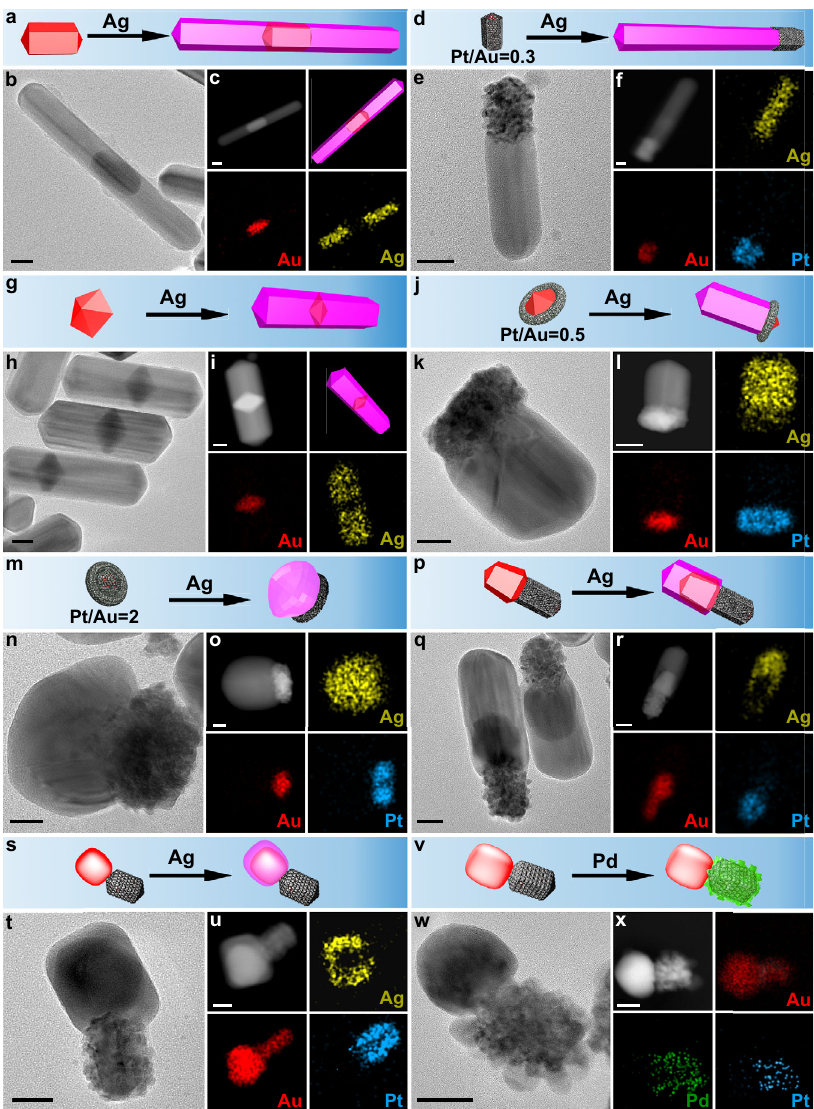
Fig. 7 Nanocrystals syntheses with tuned spatial composition. TEM images, STEM-HAADF images, STEM-EDS elemental maps, and schematic illustrations of products prepared through growing Ag on various seeds: a , b , c AuNR; d , e , f AuNR@Pt (the molar ratio of Pt and Au was 0.3); g , h , i AuND; j , k , l AuND@PtNC (the molar ratio of Pt and Au was 0.5); m , n , o AuND@PtNC (the molar ratio of Pt and Au was 2); p , q , r nanocrystals shown in 5k ; s , t , u nanocrystals shown in 5n . v , w , x TEM images, STEM-HAADF images, STEM-EDS elemental maps, and schematic illustrations of products prepared through growing Pd on nanocrystals shown in 5n . All scale bars are 20 nm. In all schematics, the red, gray, mauve, and green colors represent Au, Pt, Ag, and Pd,